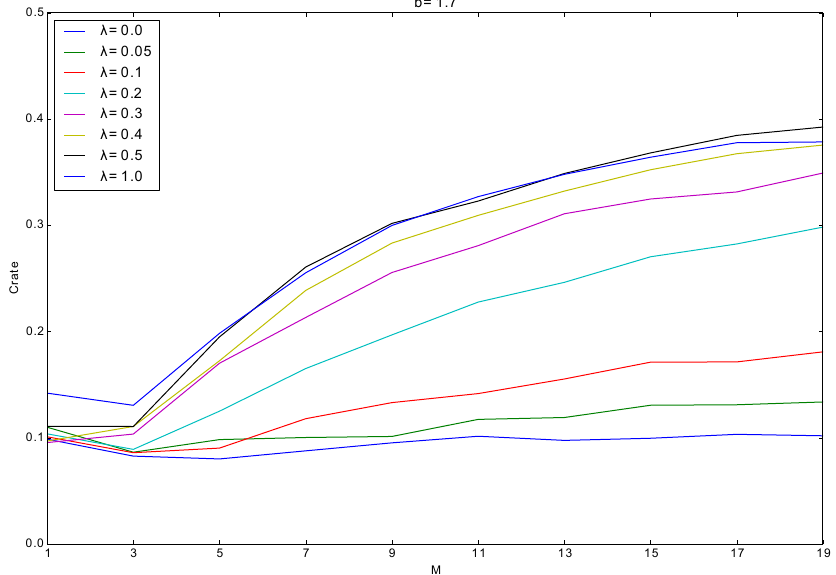
Figure 8. The proportion of cooperative behaviors among the selected strategies with the different heterogeneity among layers λ . The heterogeneity significantly contributed to the evolution of cooperation especially as M